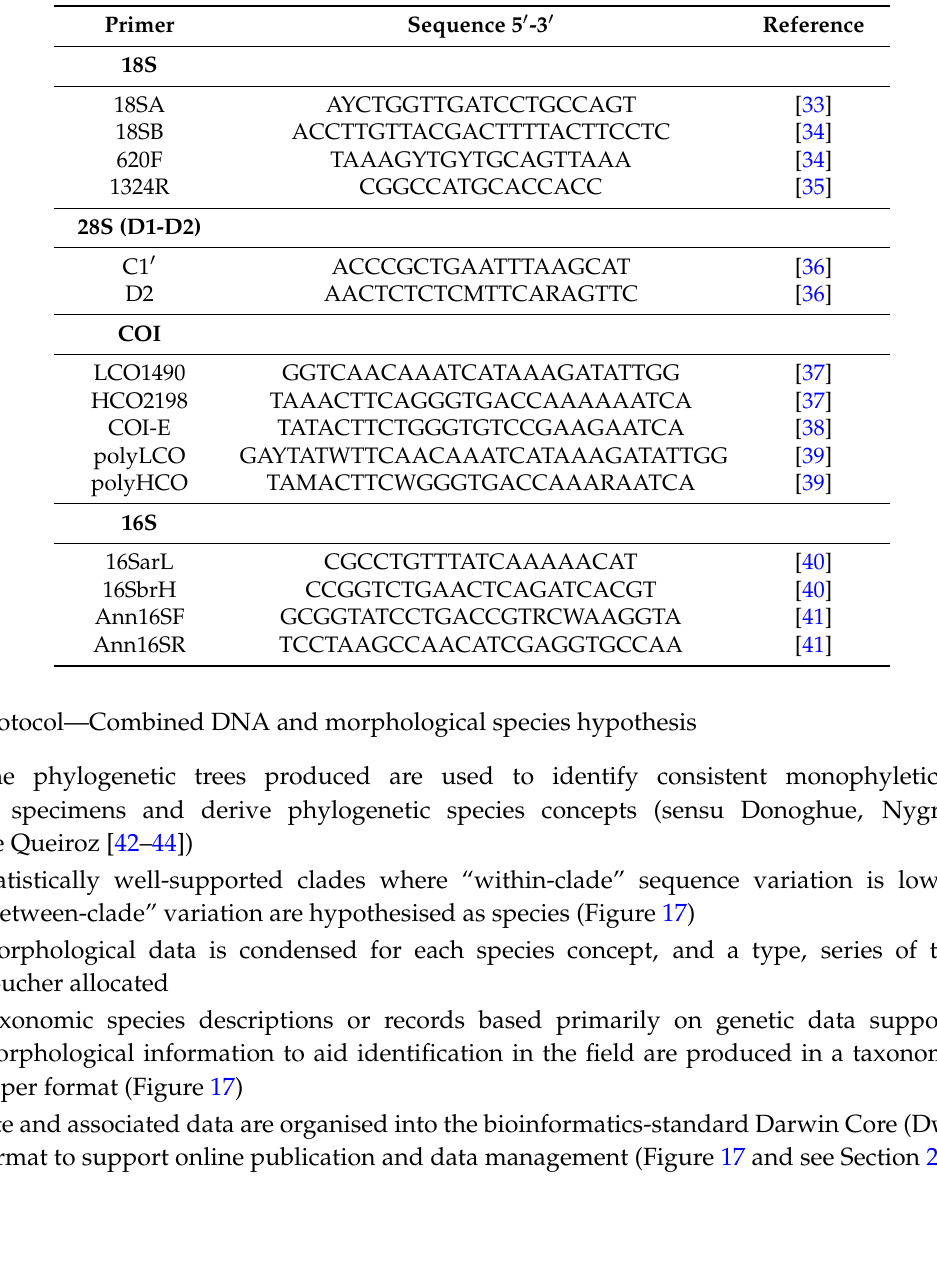
Table 1. Primers used for PCR and sequencing of all benthic CCZ mega- and macrofauna phyla except